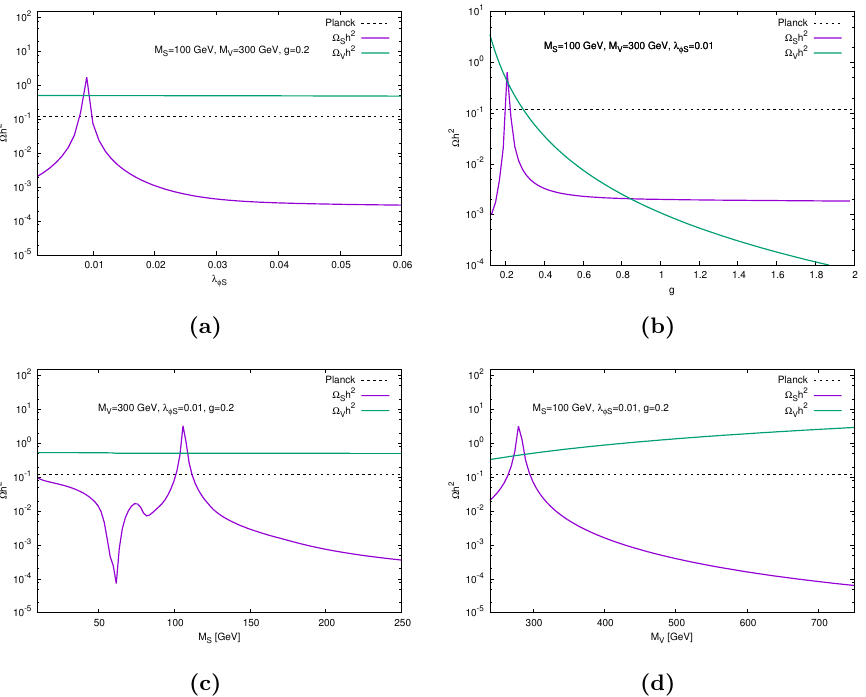
Figure 3. Variation of DM Relic density respect to parameter space.